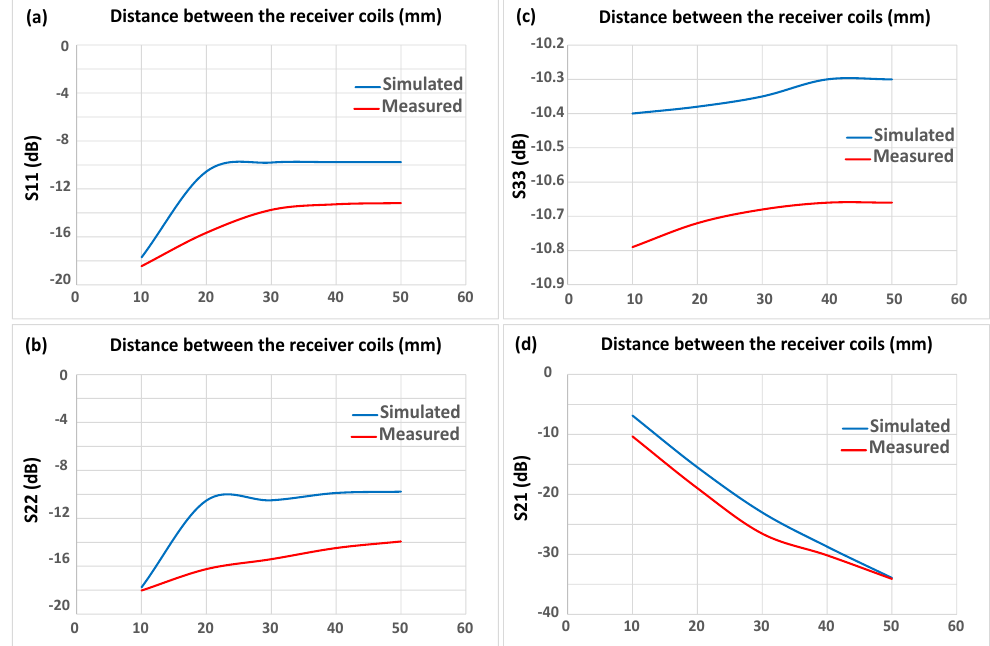
Figure 9. Comparison between the simulated and the measured results in the tissue medium: ( a ) S 11 , ( b ) S 22 , ( c ) S 33 , ( d ) S 21